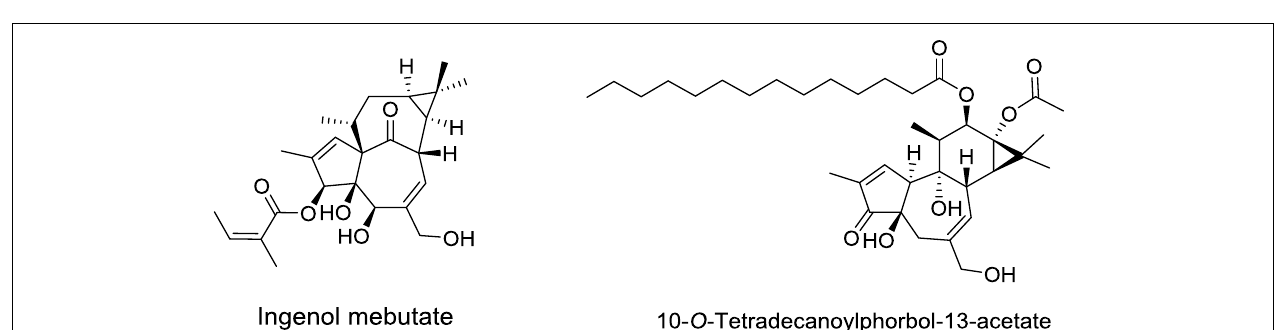
FIGURE 5 | Structures of epoxomicin, YU-101, carfilzomib.